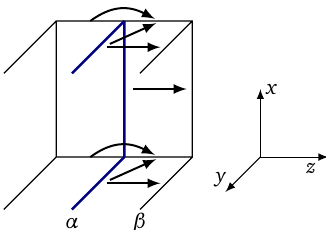
Figure 10: The finite depth local unitary to remove an x y toric code leaf ( α ) from an X-cube model near a rough boundary along the xz plane.